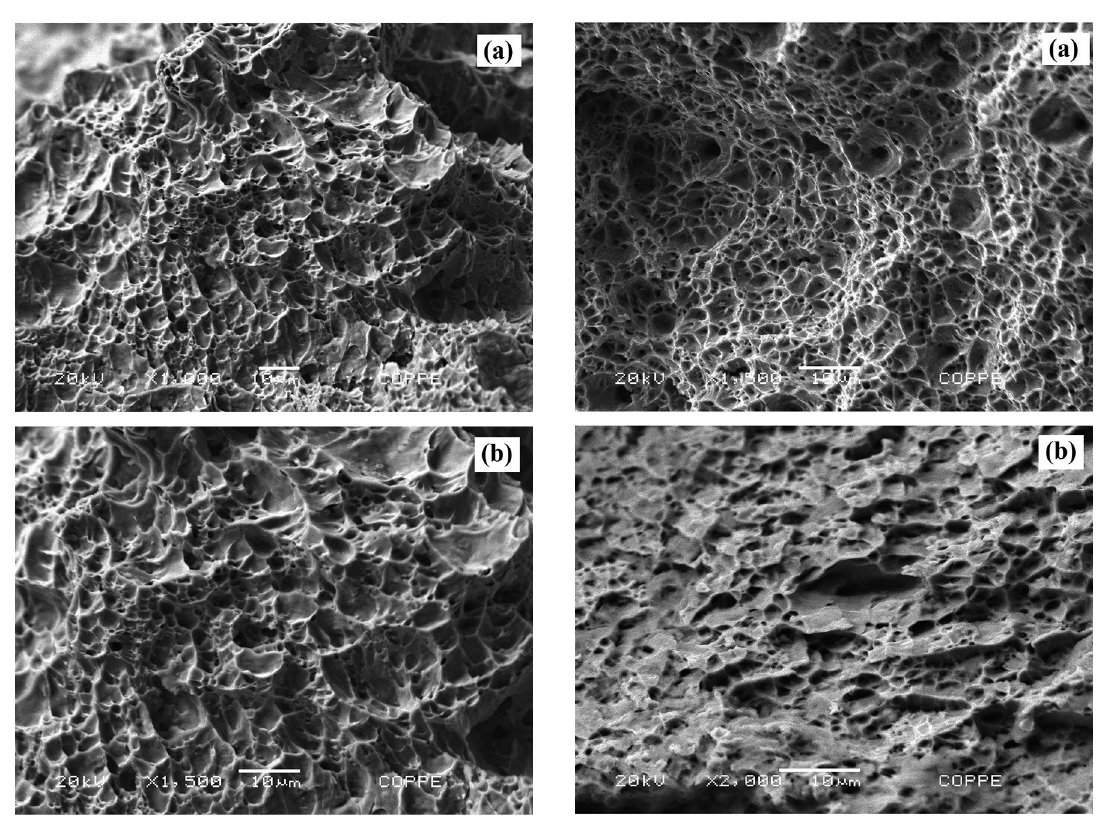
Figure 12: SEM of fracture surface after uniaxial tensile test specimens of the base metal (BM): a) as received (AR), b) hydrogenated after heat treatment